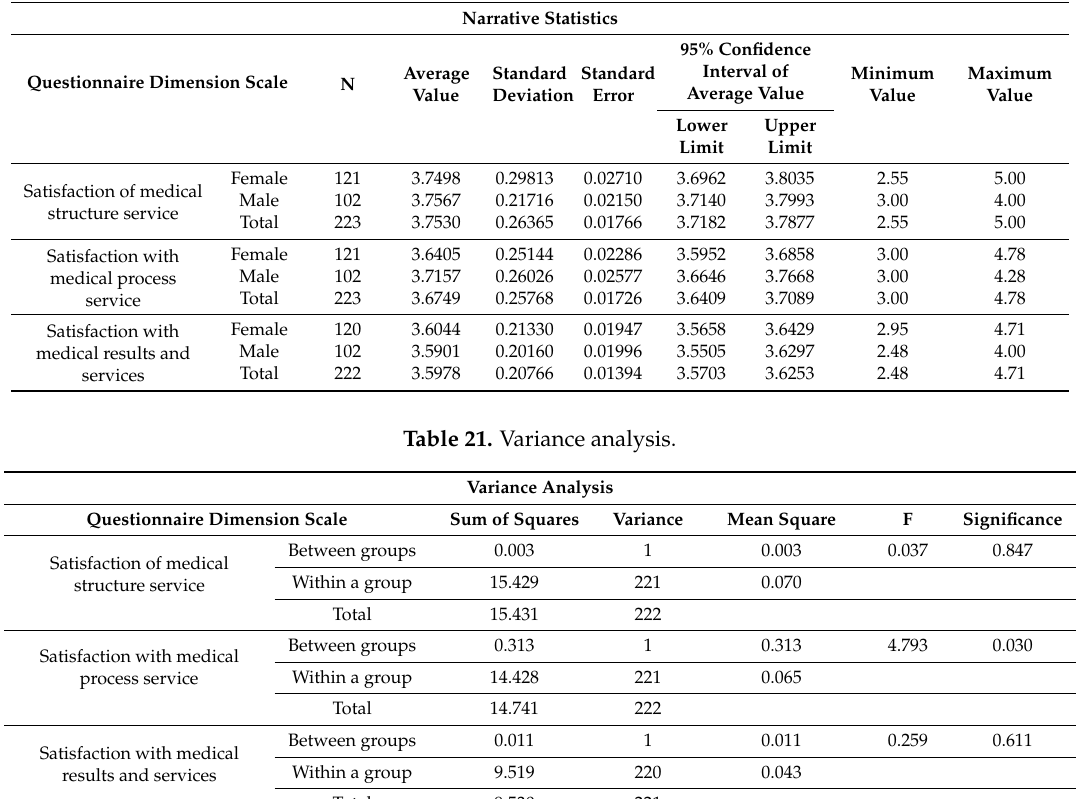
Table 20. Analysis of gender and scale dimension variables.